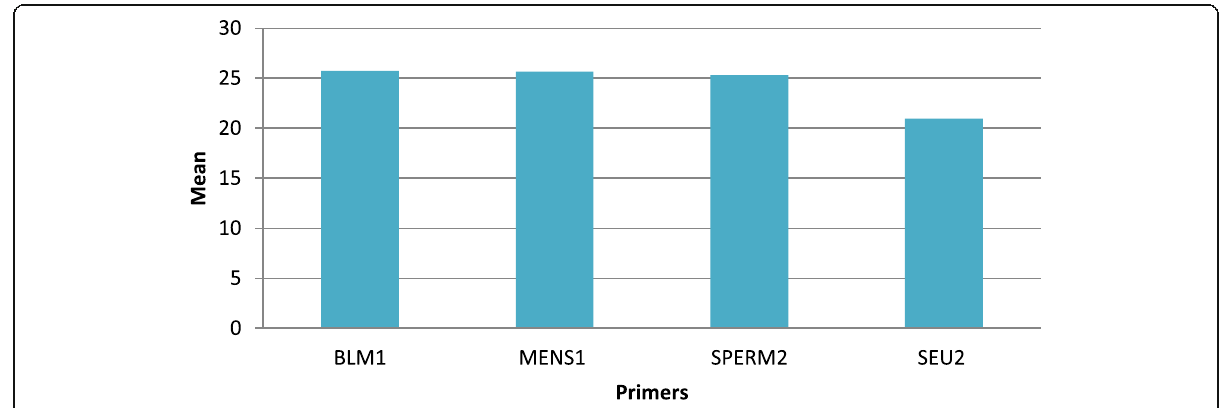
Fig. 2 Comparison between the mean of Cq values in individual body fluid samples